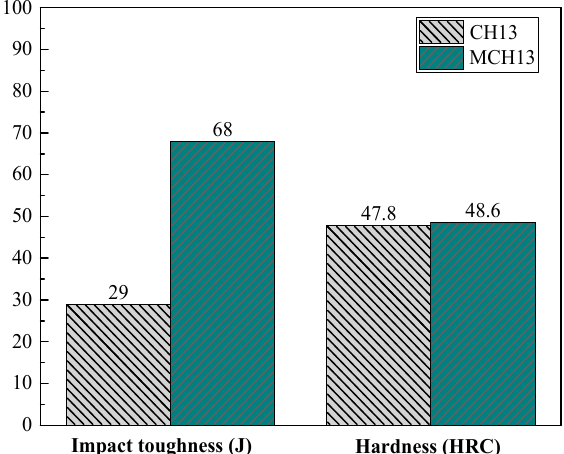
Figure 6. Impact toughness of tempered CH13 and MCH13 steels [49].